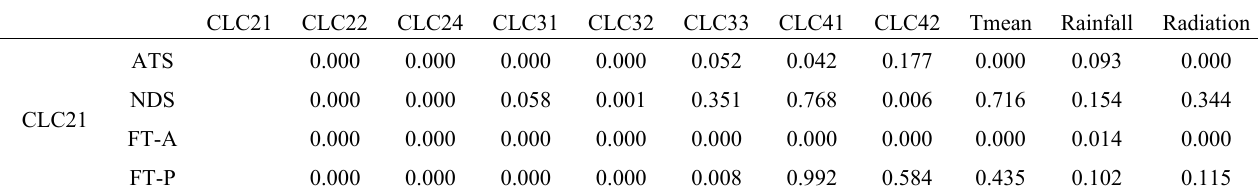
Table 6. P -values of Pearson bivariate correlations of EVI and climatic variables for the datasets: anomaly time series (ATS), normalized D/S (NDS), amplitude term of the Fourier Transform (FT-A), and phase term of the Fourier Transform (FT-P) obtained for the EVI and selected climatic variables time